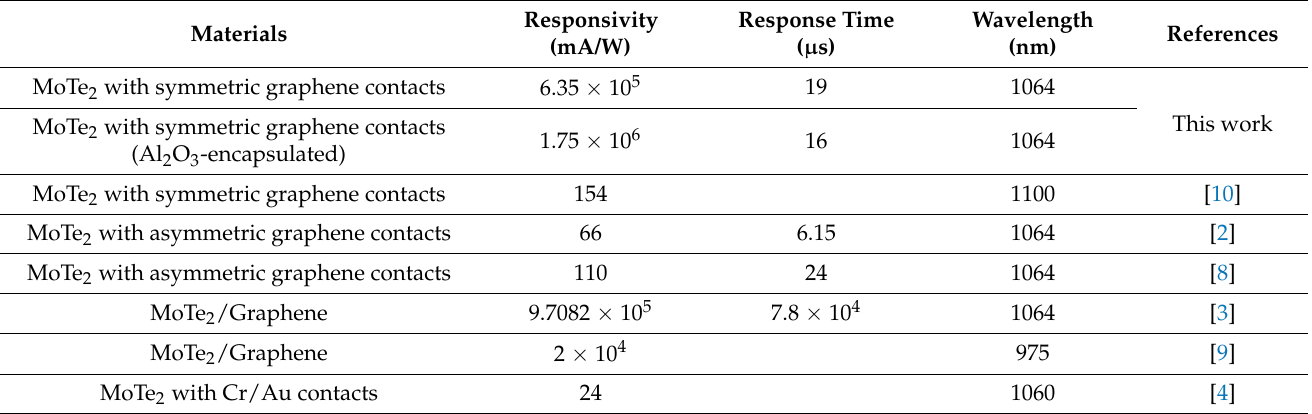
Table 1. Comparison of our graphene–MoTe 2 —graphene vertical vdWs heterostructure photodetec- tors and other MoTe 2 -based NIR photodetectors in the